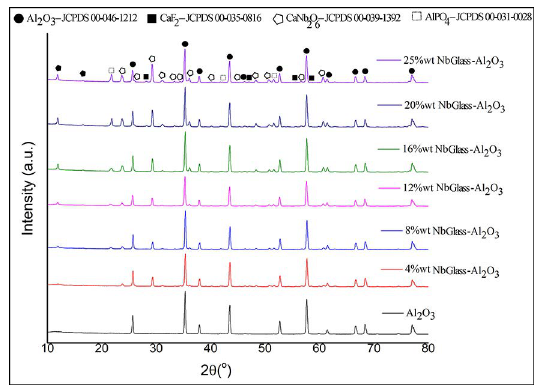
Figure 2. XRD results of the sintered samples.